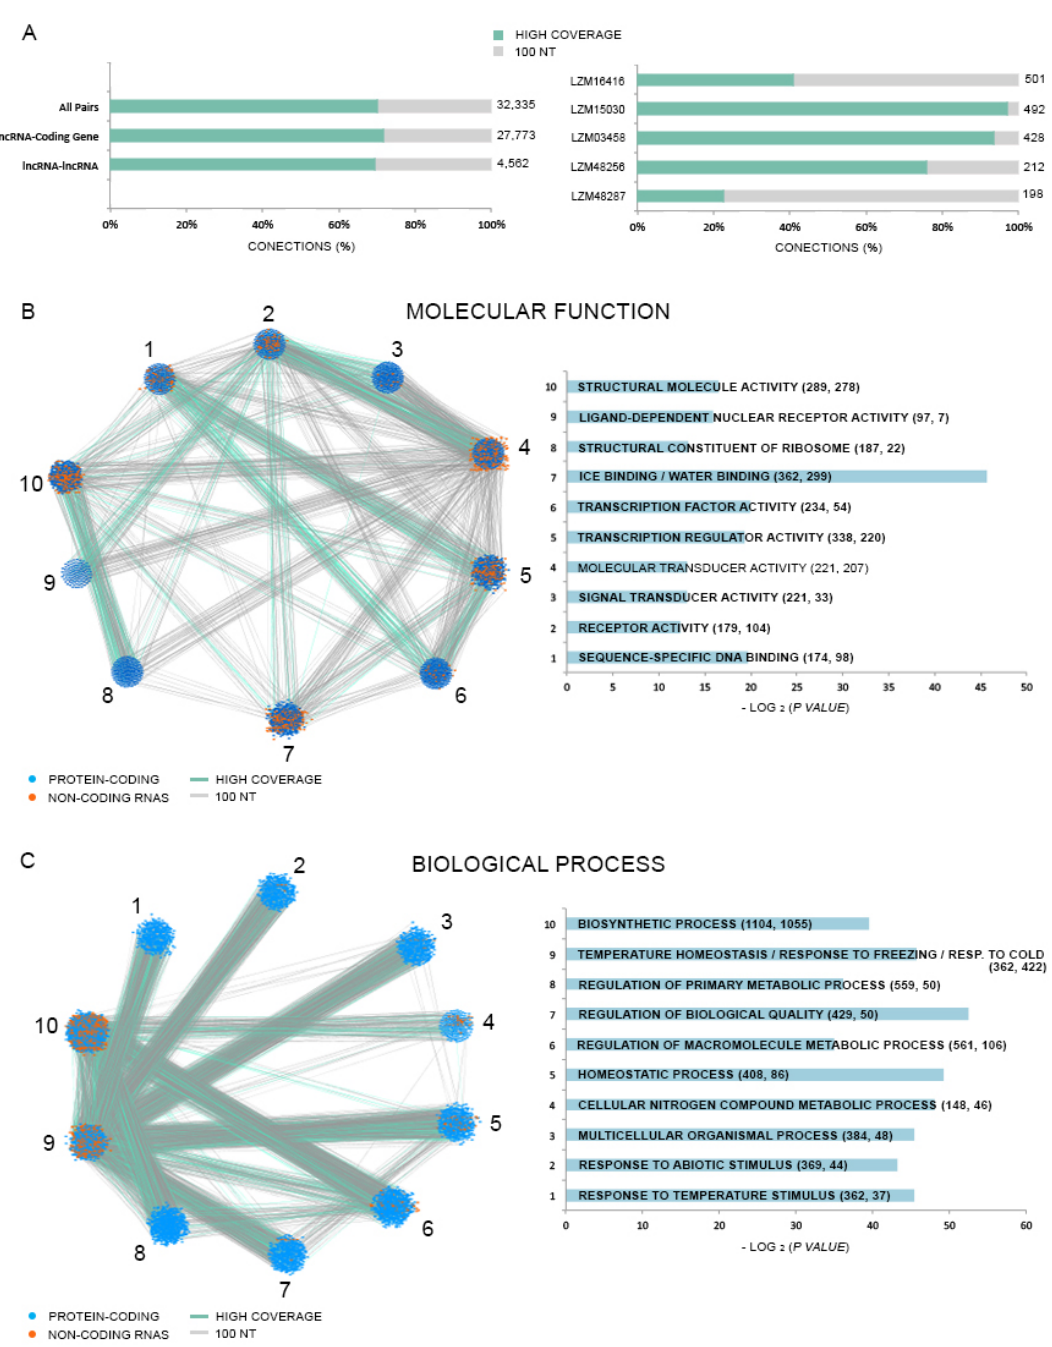
Figure 7. ( A ) On the left, we have the distribution of trans natural transcript ( trans -NAT) pairs according to its classification (high-coverage or 100 nt), and the target transcripts type (coding genes or lncRNAs). On the right, we have the top five lncRNAs with the most target transcripts; ( B , C ) Network and histogram of the top ten ‘molecular function’ and ‘biological process’ enriched Gene Ontology (GO) categories, respectively.